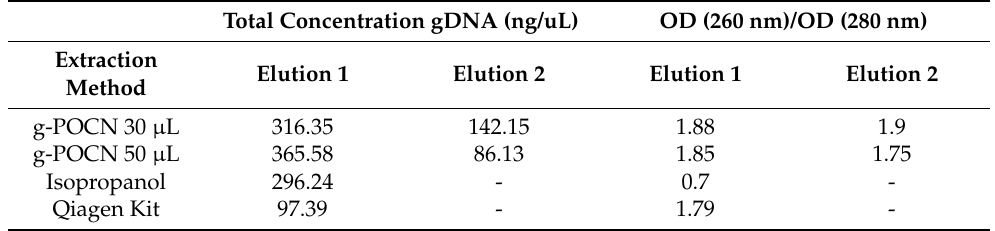
Table 2. gDNA extraction yields and relationship between the absorptions at 260/280 nm using different